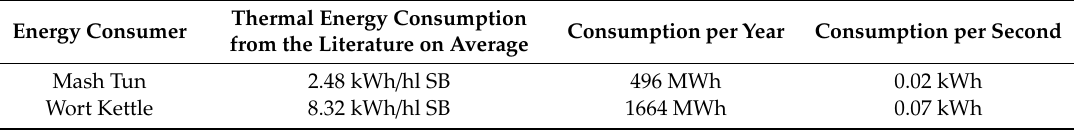
Table 1. Thermal energy consumption data of the consumers in the brewhouse.